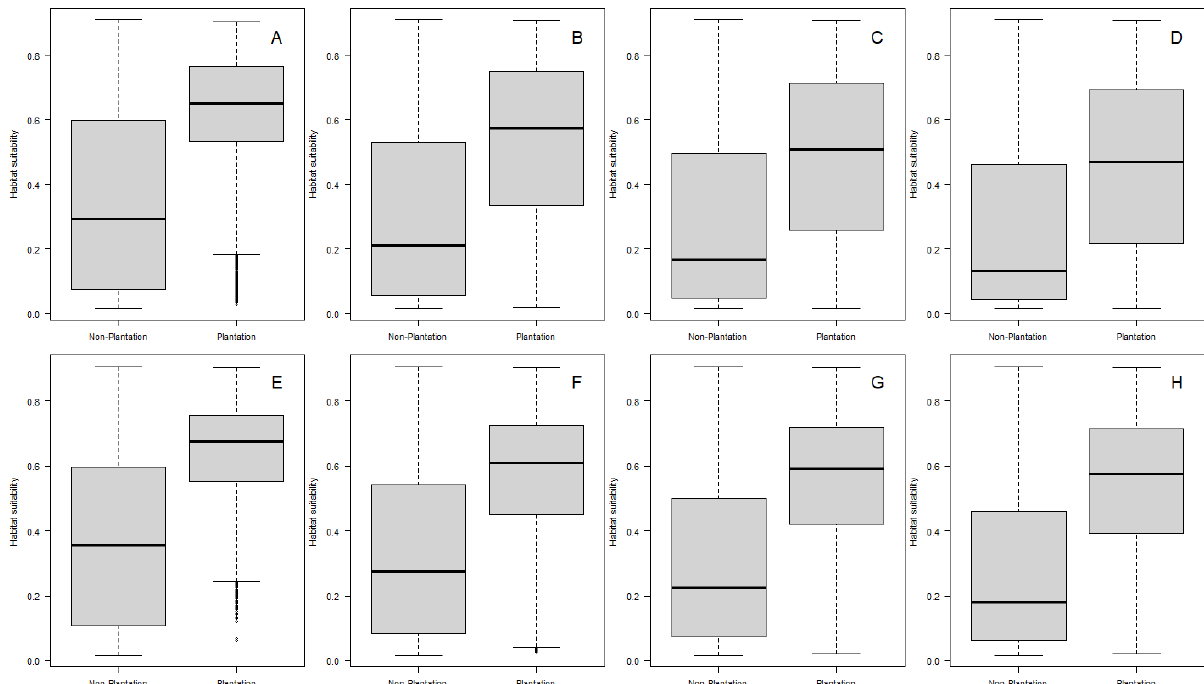
Figure 8. Boxplots comparing Anopheles albimanus habitat suitability in plantations and non-plantation landscapes from plantation districts for oil palms ( A ) without a spatial buffer, t = 170.01, df = 13,879, p -value < 2.2 × 10 − 16 , ( B ) with a 1 km spatial buffer, t = 200.54, df = 99,252, p -value < 2.2 × 10 − 16 , ( C ) with a 2 km spatial buffer, t = 204.02, df = 209,115, p -value < 2.2 × 10 − 16 and ( D ) with a 3 km spatial buffer, t = 210.34, df = 298,572, p -value < 2.2 × 10 − 16 ; and for pineapples ( E ) without a spatial buffer, t = 177.12, df = 14,391, p -value < 2.2 × 10 − 16 , ( F ) with a 1 km spatial buffer, t = 242.18, df = 107,952, p -value < 2.2 × 10 − 16 , ( G ) with a 2 km spatial buffer, t = 262.72, df = 172,789, p -value < 2.2 × 10 − 16 and ( H ) with a 3 km spatial buffer, t = 278.23, df = 208,638, p -value < 2.2 × 10 − 16 . In all panels, the boxplots show the median for the distribution of pixel values, while the boxes represent the 25th and 75th percentiles of the data. For each boxplot comparison, we report t values for two-sample Welch’s t tests, a statistic used to compare means between two groups, in this case plantation vs. non-plantation pixels. We chose Welch’s t test for the comparison because it accounts for heterogeneous variances in the compared groups [86].